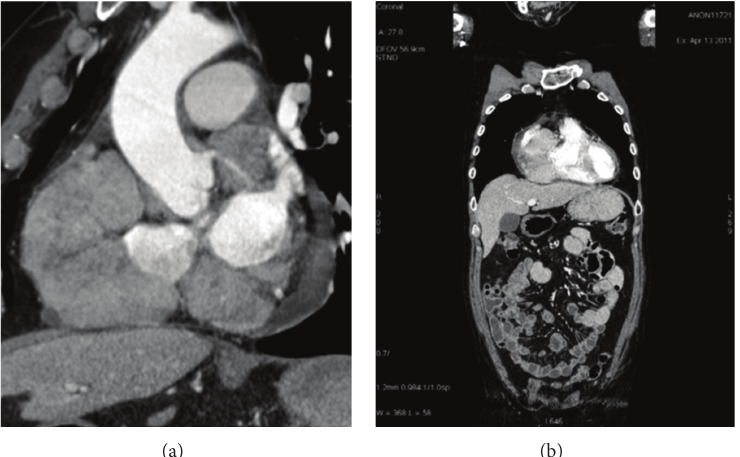
Figure 2: (a) Sagittal reconstruction; (b) coronal reconstruction. CT shows the presence of right atrium myocardial mass and no other abnormality in other